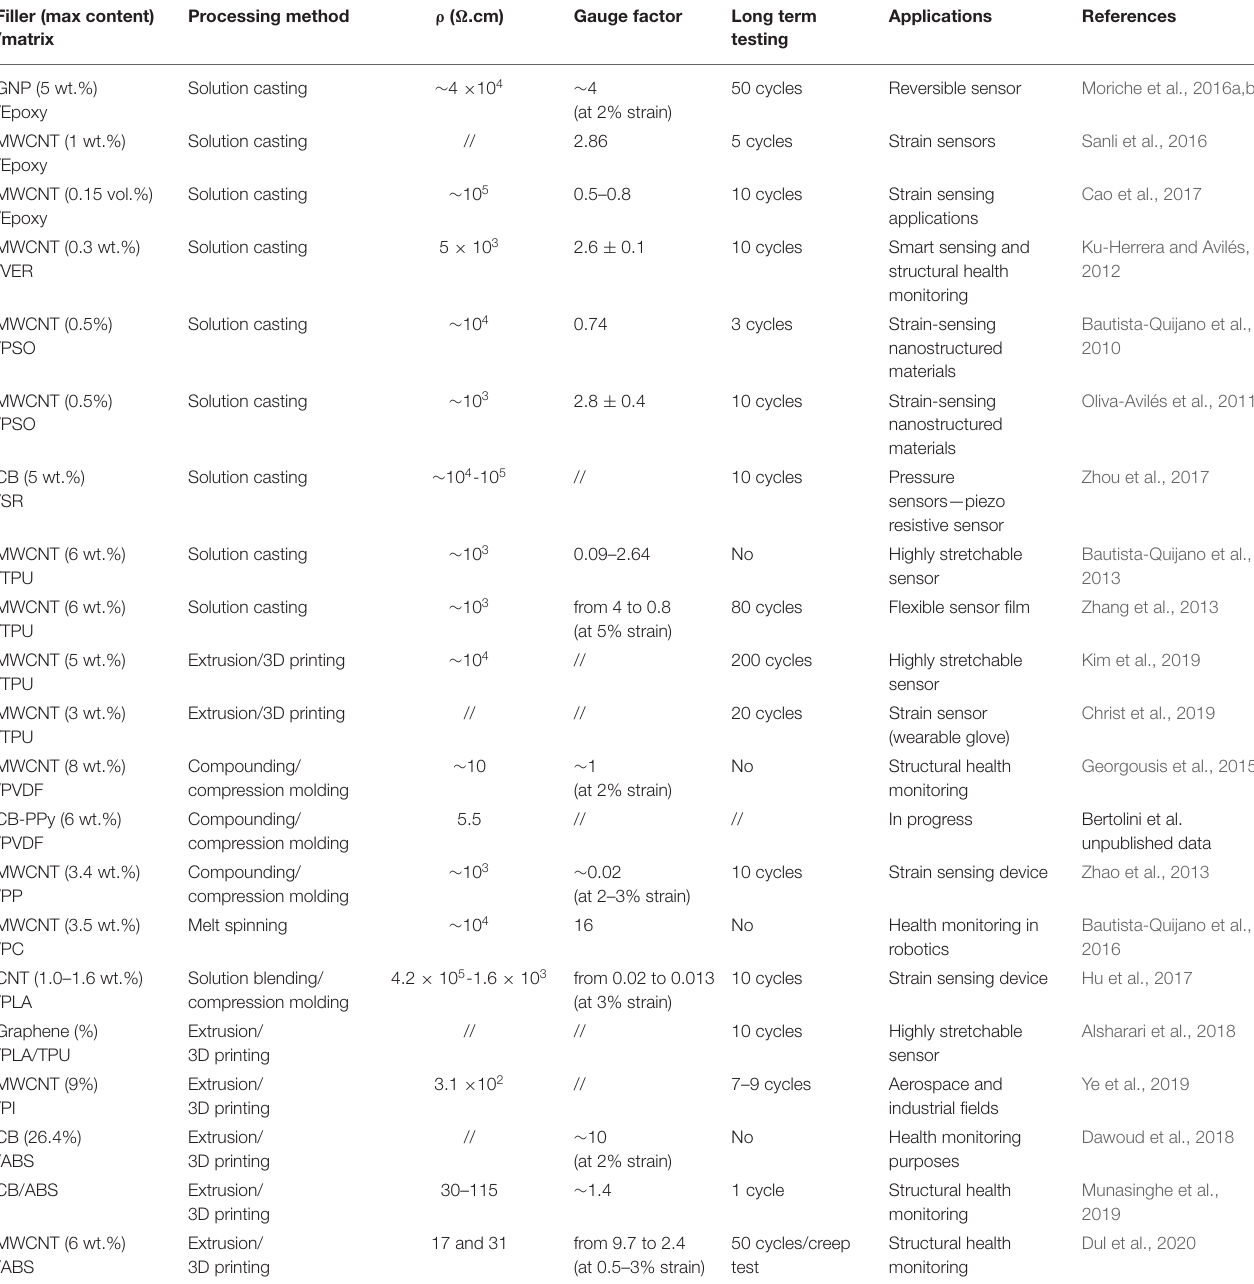
TABLE 3 | Comparison of resistivity and piezoelectric behavior of polymer composites filled with carbon nanostructures and produced with different matrix and process. Filler (max content)